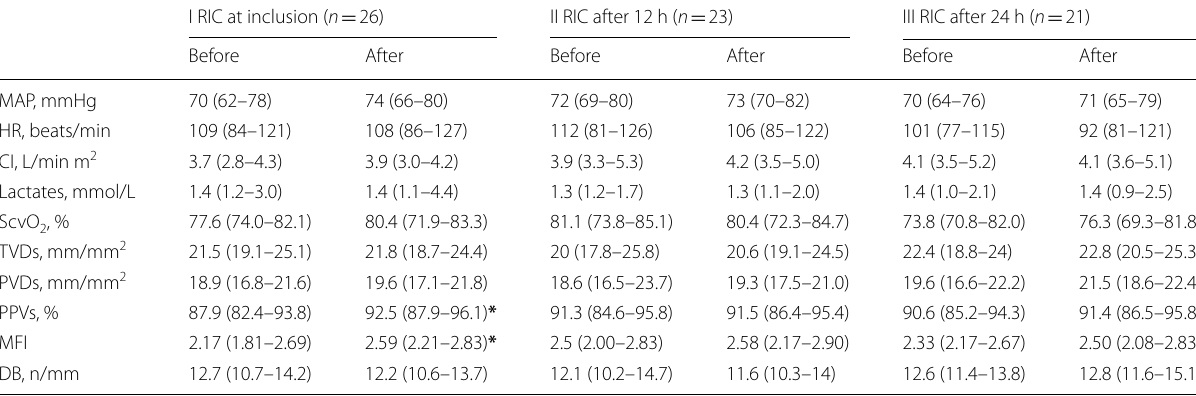
Data are presented as the median (interquartile range [IQR]) MAP mean arterial pressure, HR heart rate, CI cardiac index, TVDs total vascular density of small vessels, PVDs perfused small vessel density, PPVs proportion of perfused small vessels, MFI microcirculatory flow index, DB De Backer score, ScvO 2 central venous oxygen